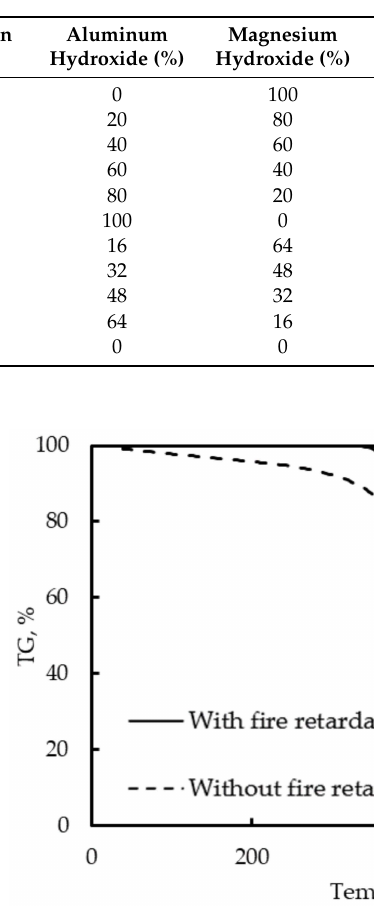
Table 3. Residual mass results of the asphalt.